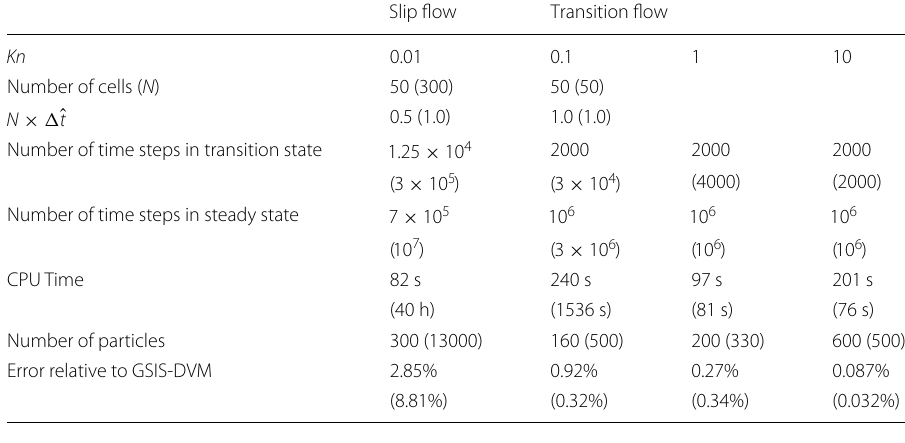
Table 3 Parameters adopted in GSIS-LVDSMC and LVDSMC (values in parentheses) algorithms in the simulation of 1D Fourier flow